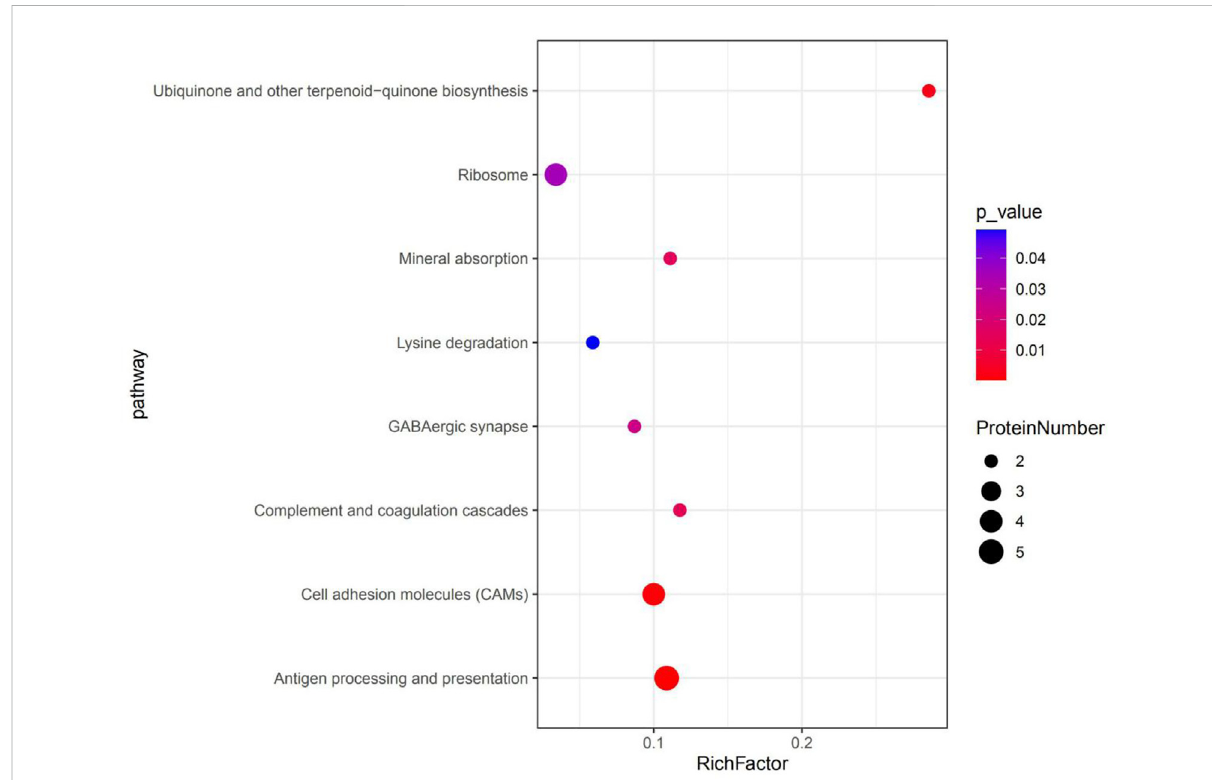
FIGURE 9 ThetopeightKEGGpathwaysenrichedinDSEPs.The X -axisrepresentsthecorrespondingpathwayenrichmentscore;the Y -axisrepresentsthe name of each pathway. The enrichment score is the ratio of the number of DSEPs in the pathway to the number of all annotated proteins in the